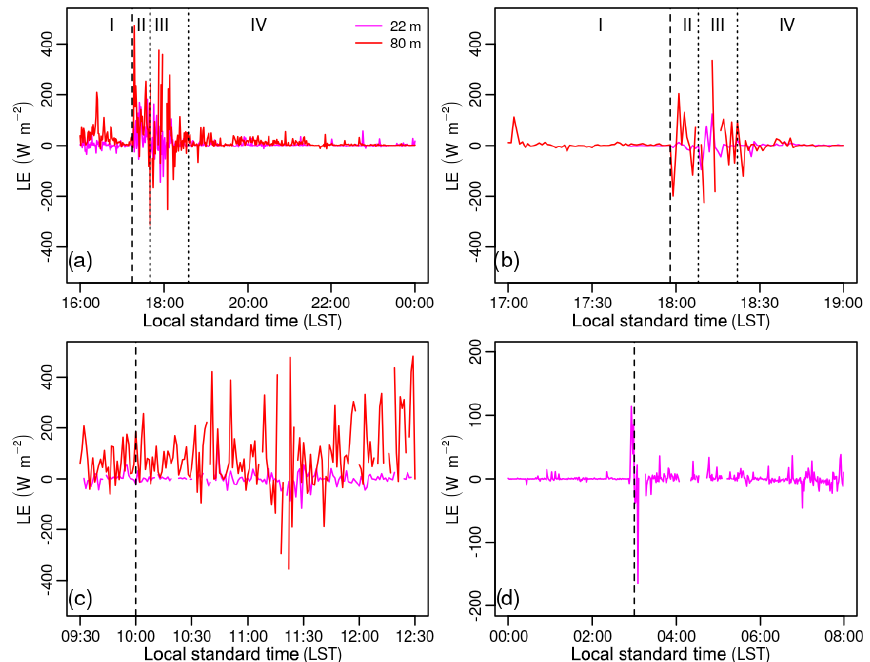
Figure 6. The same as in Fig. 2 but for latent heat